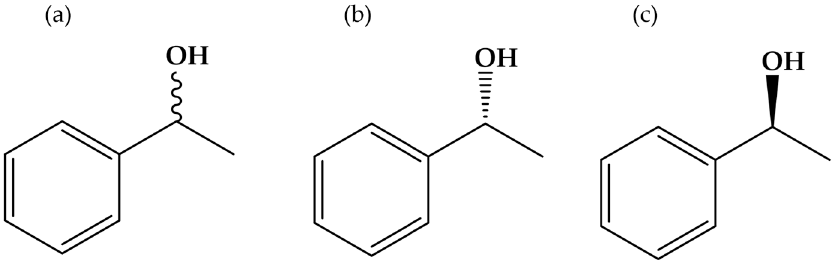
Figure 1. The structures of ( R , S )-1-phenylethanol ( a ), and enantiomers: ( R )-1-phenylethanol ( b ), and ( S )-1-phenylethanol ( c